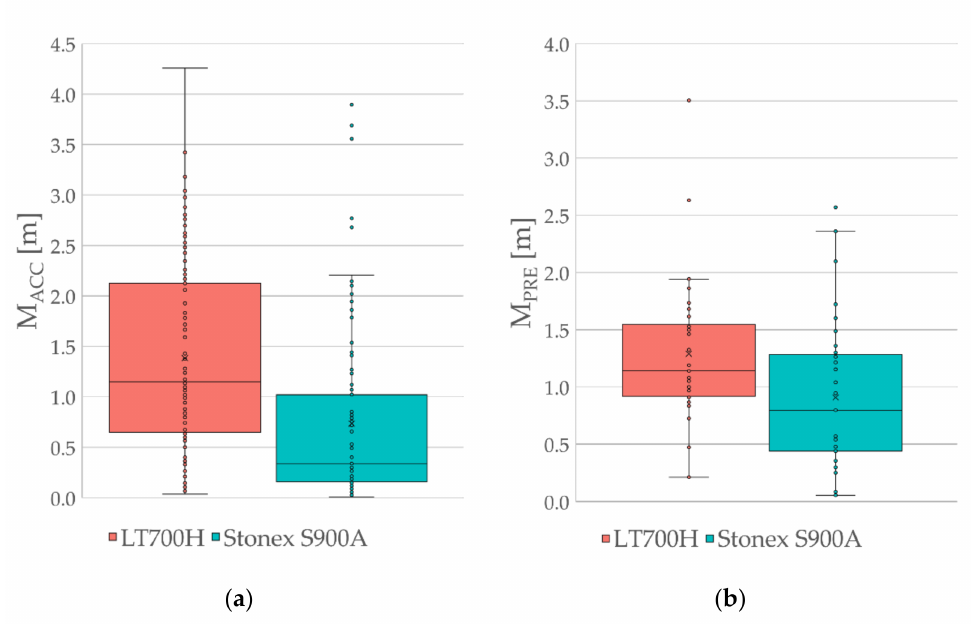
Figure 4. The overall accuracy ( a ) and precision ( b ) depending on the used receiver.